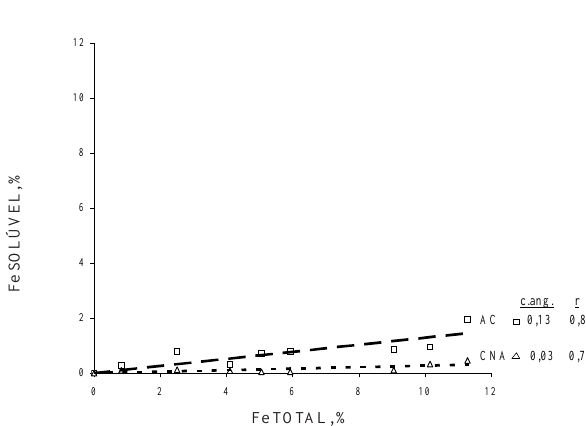
Figura 2. Solubilidade do ferro presente em fertilizantes insolúveis em água, nos diversos extratores utilizados, e respectivos coeficientes angulares das retas (c.ang.) e coeficientes de correlação (r). ** e * significativos a 5 e 1%.